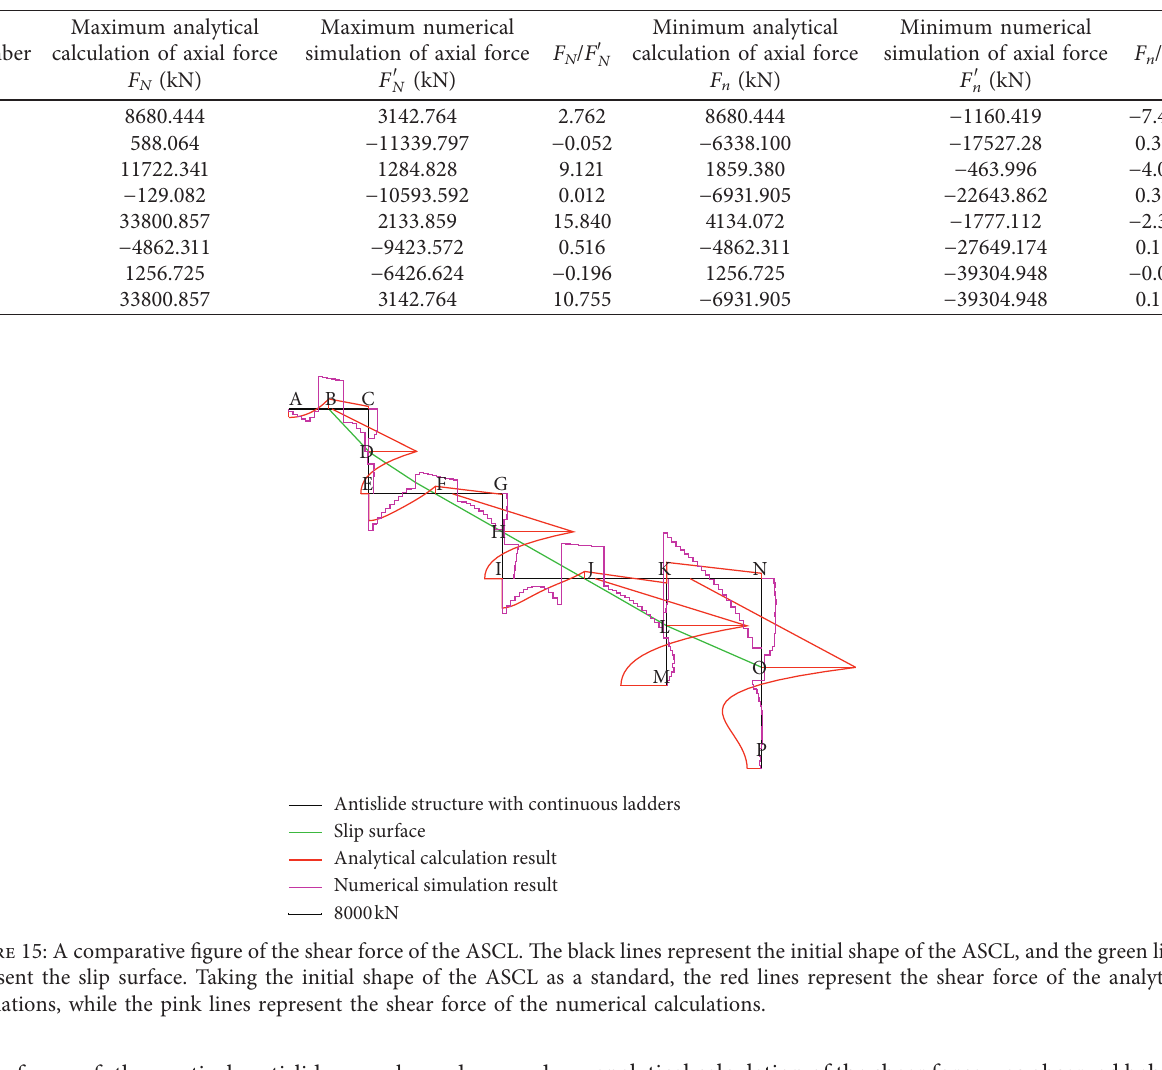
Table 5: A comparative table of the axial force of the antislide members.